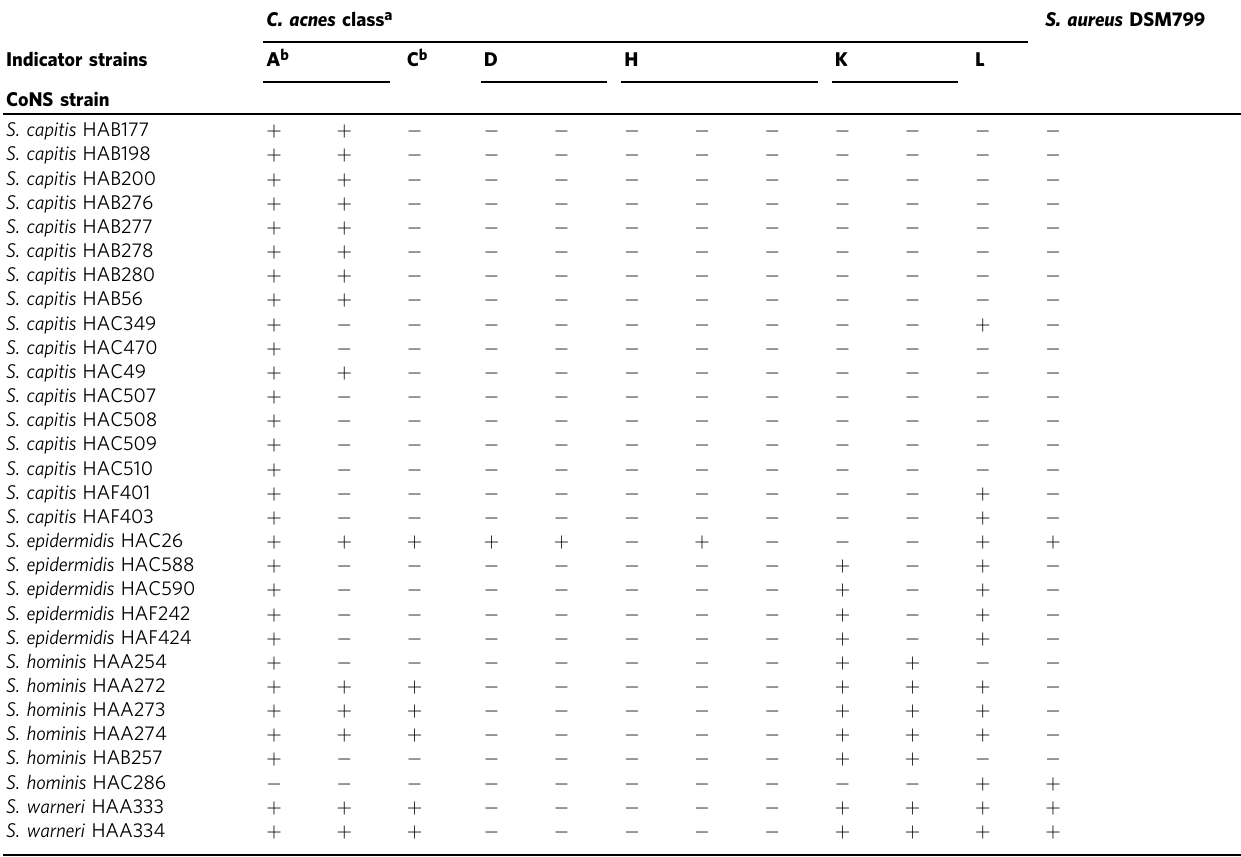
Table 1 Antimicrobial activity of staphylococci against C. acnes strains from six different SLST classes and S. aureus